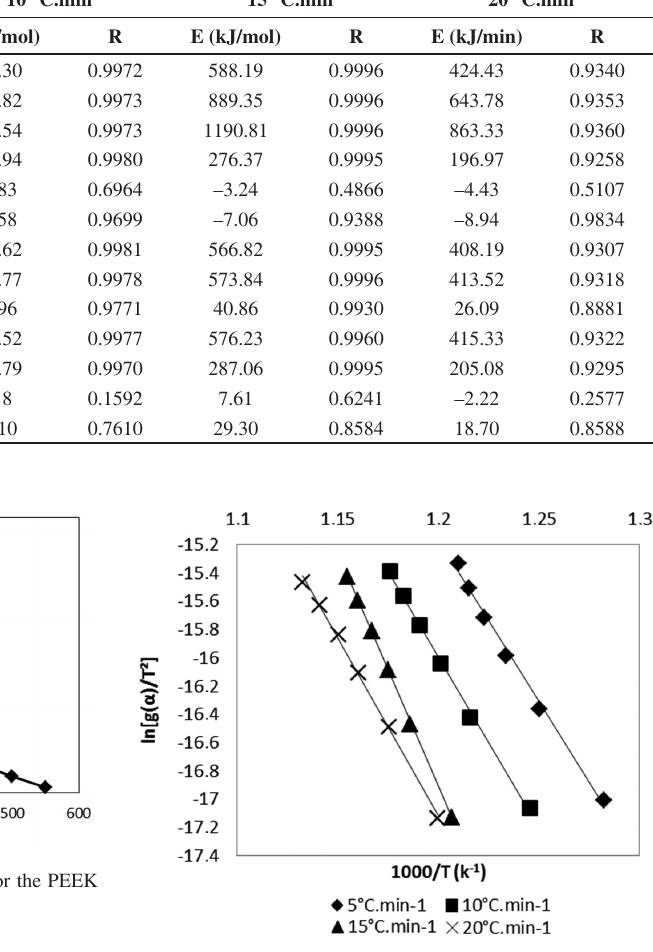
Figure 12. R1 equation adjusted to the Coats-Redfern method in the heating rates of 5 °C.min –1 ; 10 °C.min –1 ; 15 °C.min –1 and 20 °C.min –1 .